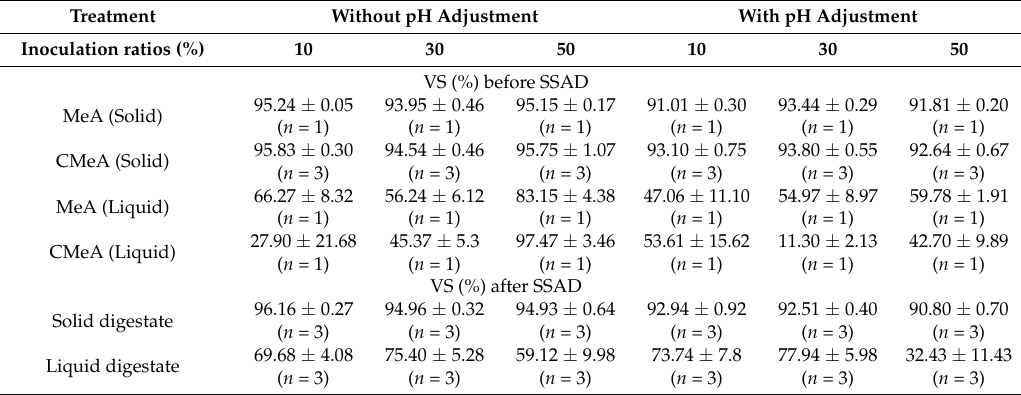
Table 3. Comparison of VS of MeA mixture, dairy cattle manure/MeA mixture (CMeA), and digestate among